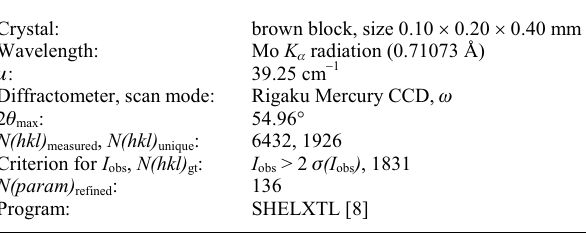
Table 1. Data collection and